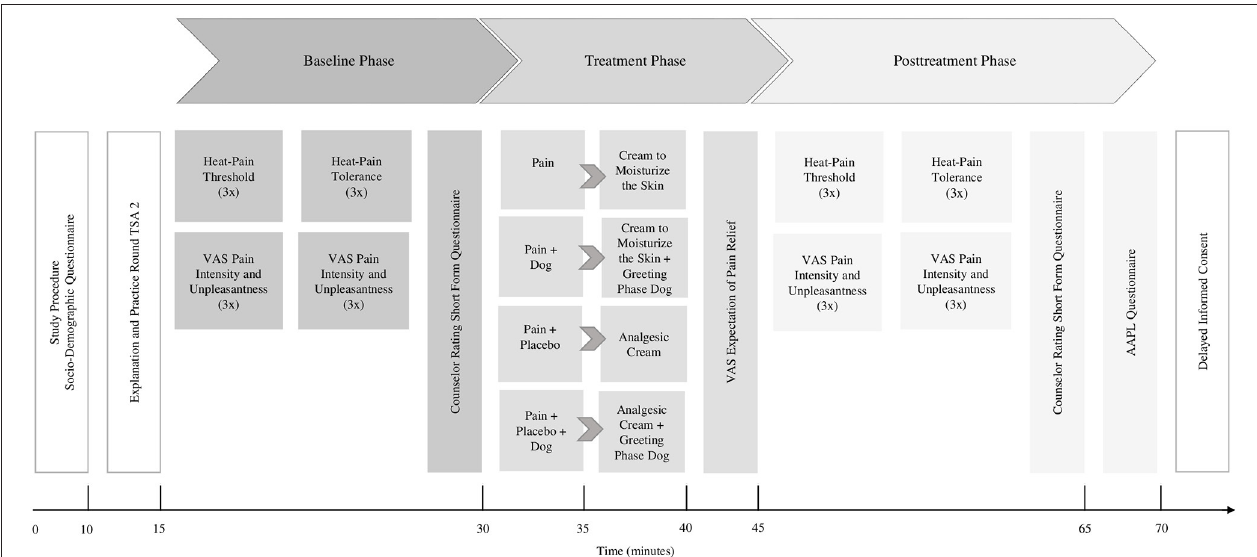
FIGURE 1 | Timeline of the study